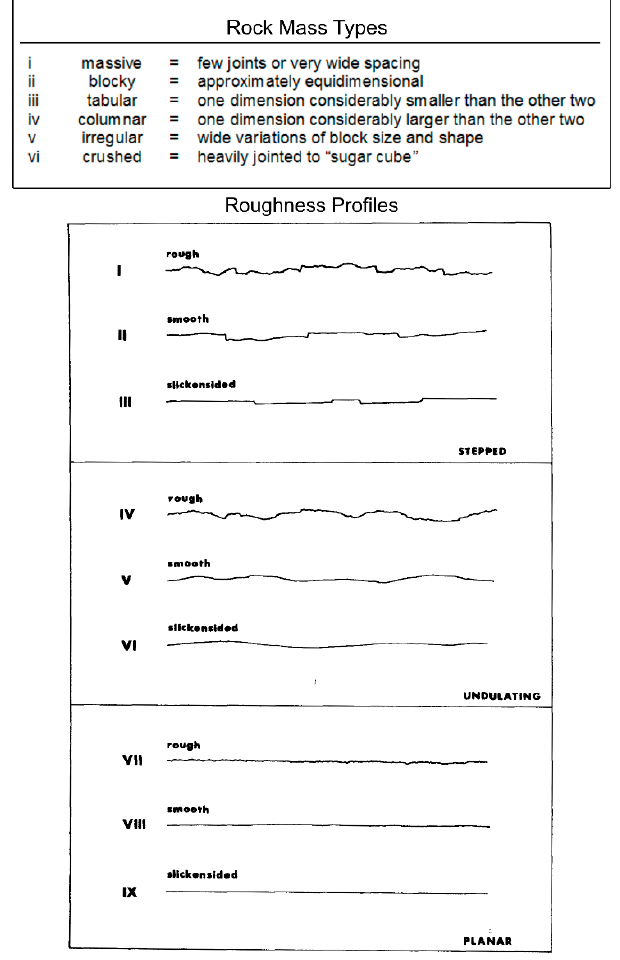
Figure 2. Example of tables for geotechnical data codes (adapted from ISRM [16]).